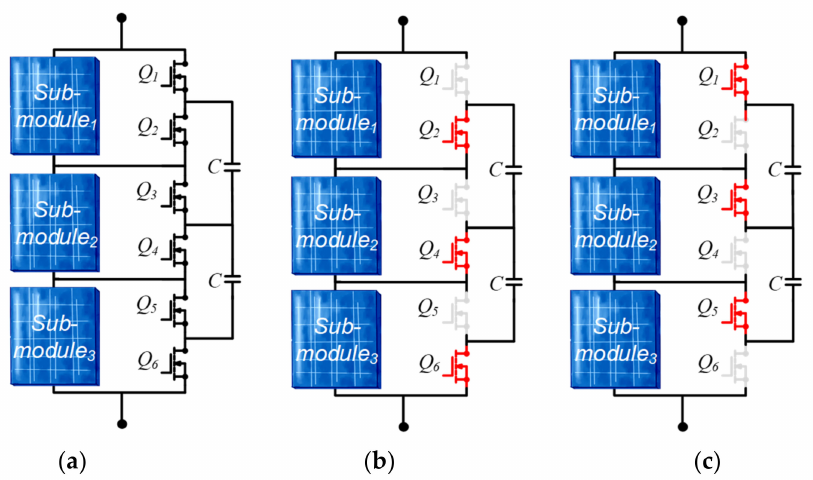
Figure 7. Switched-capacitor (SC)-based differential power processing (DPP) converter: ( a ) general schematic, ( b ) switching state/mode 1, and ( c ) switching state/mode